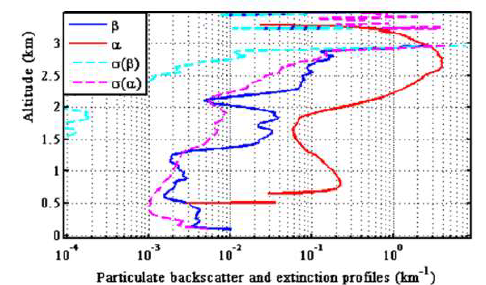
Fig. 2 : Profiles of HSR measurements over the aerosol layer a) particulate backscatter coefficient (km -1 sr -1 ) and extinction coefficient (km -1 ) with related errors (standard deviation).